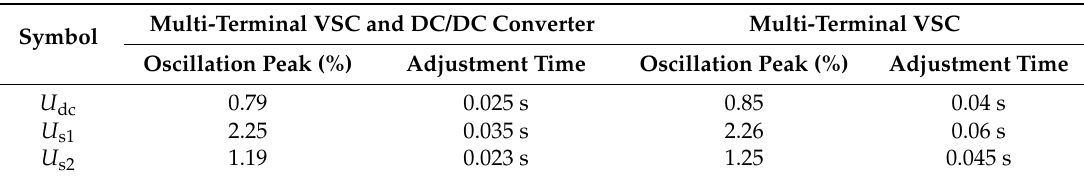
Table 2. Comparison of two kinds of active stabilization control.